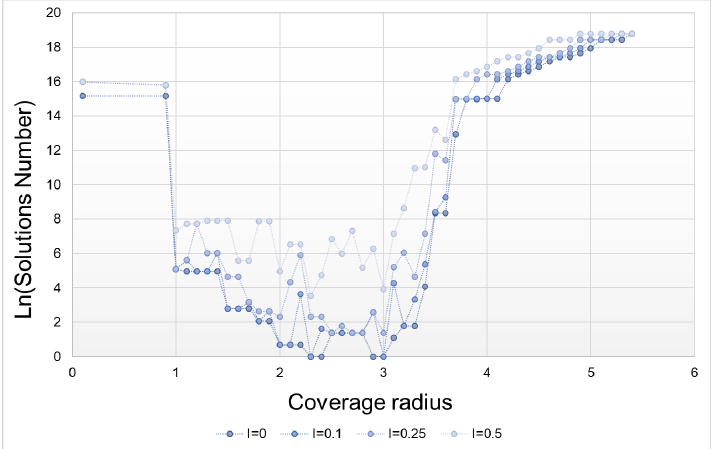
Figure 8. Influence of the uncertainty on the number of solutions according coverage radius (Meller’s scenario).